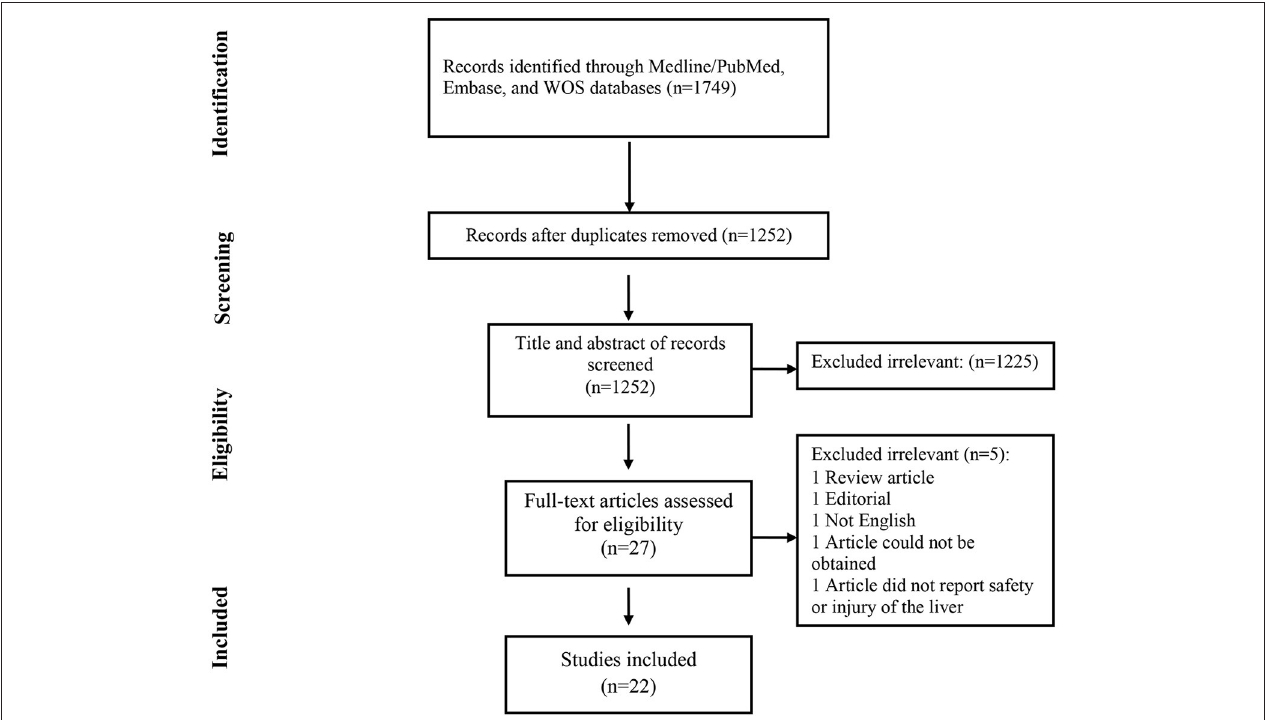
FIGURE 1 | Flow chart of study selection for inclusion in the systematic